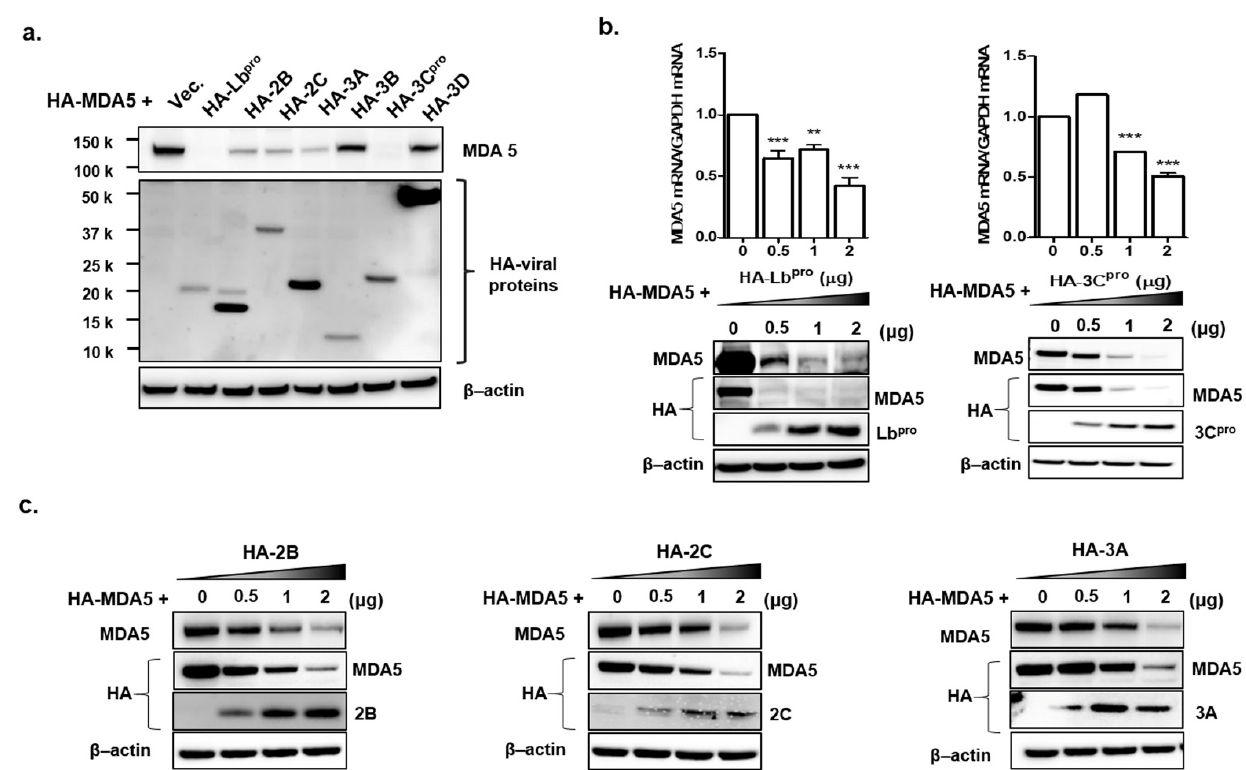
Figure 3. The effects of Lb pro and 3C pro on exogenous MDA5 protein expression. ( a ) HEK293T cells (1 × 10 6 cells) were co-transfected with HA-tagged MDA5-expressing plasmid (2 µg) and various plasmids expressing HA-tagged viral nonstructural proteins (Lb, 2B, 2C, 3A, 3B, 3C or 3D) or empty HA-vector plasmid (2 µg). The expression of HA-tagged NSP and MDA5 was determined by Western blotting at 16 h. ( b ) HEK293T cells (1 × 10 6 cells) were transfected with HA-tagged MDA5-expressing plasmid (2 µg) along with different amounts of HA-Lb or 3C expressing plasmid (0, 0.5, 1 or 2 µg). The expression of MDA5 mRNA was detected by real-time RT-PCR normalized to GAPDH (upper panel) and levels of proteins were analyzed by Western blotting with anti-HA, MDA5 and β -actin antibodies at 16 h. The values of mRNA levels are presented as mean ± SEM (**, p < 0.01; ***, p < 0.001). ( c ) HEK293T cells (1 × 10 6 cells) were transfected with HA-tagged MDA5-expressing plasmid (2 µg) along with different dose of HA-NSP (2B, 2C or 3A) expressing plasmid (0, 0.5, 1 or 2 µg) for 16 h. The expression of HA-tagged NSP and MDA5 proteins in cell lysates were analyzed by Western blotting with anti-HA, MDA5 antibodies. All the tests were conducted three times independently and data are shown from one of the triplicate experiments.